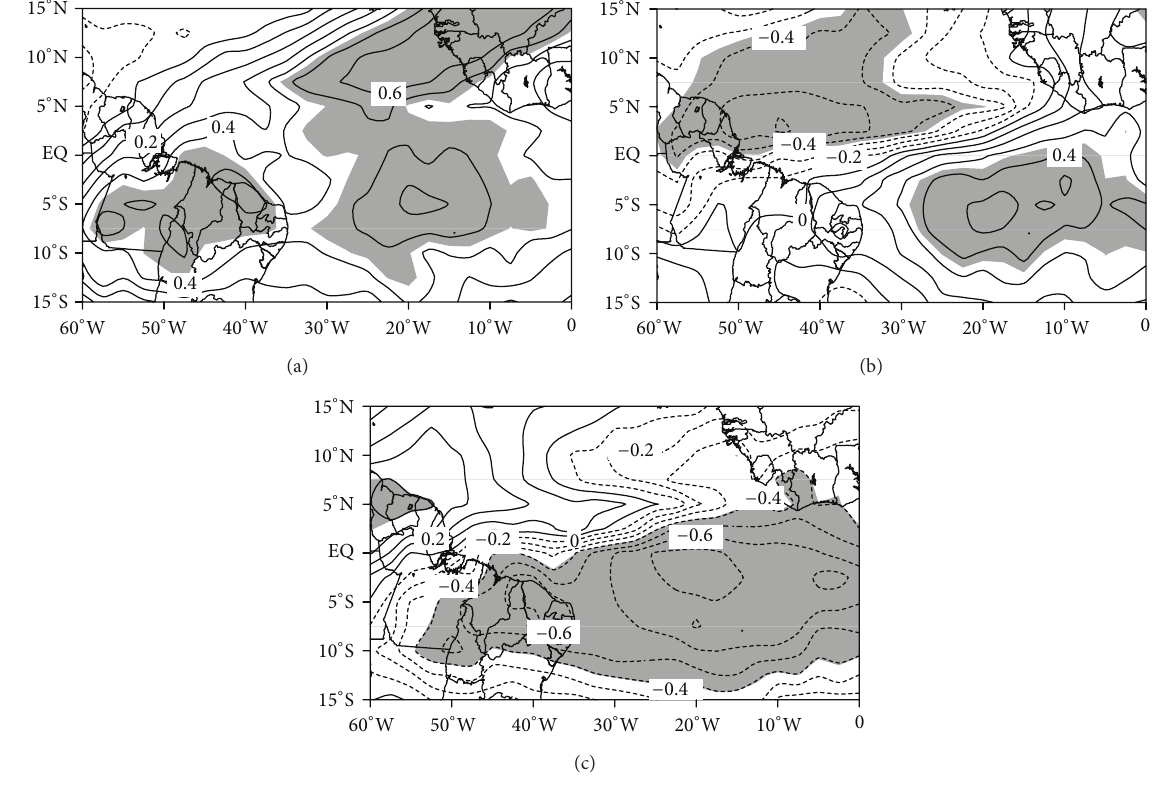
Figure 2: Spatial pattern of (a) EOF1 for February, (b) EOF2 for March, and (c) EOF1 for April performed on pentad OLR anomalies (1983– 2012).